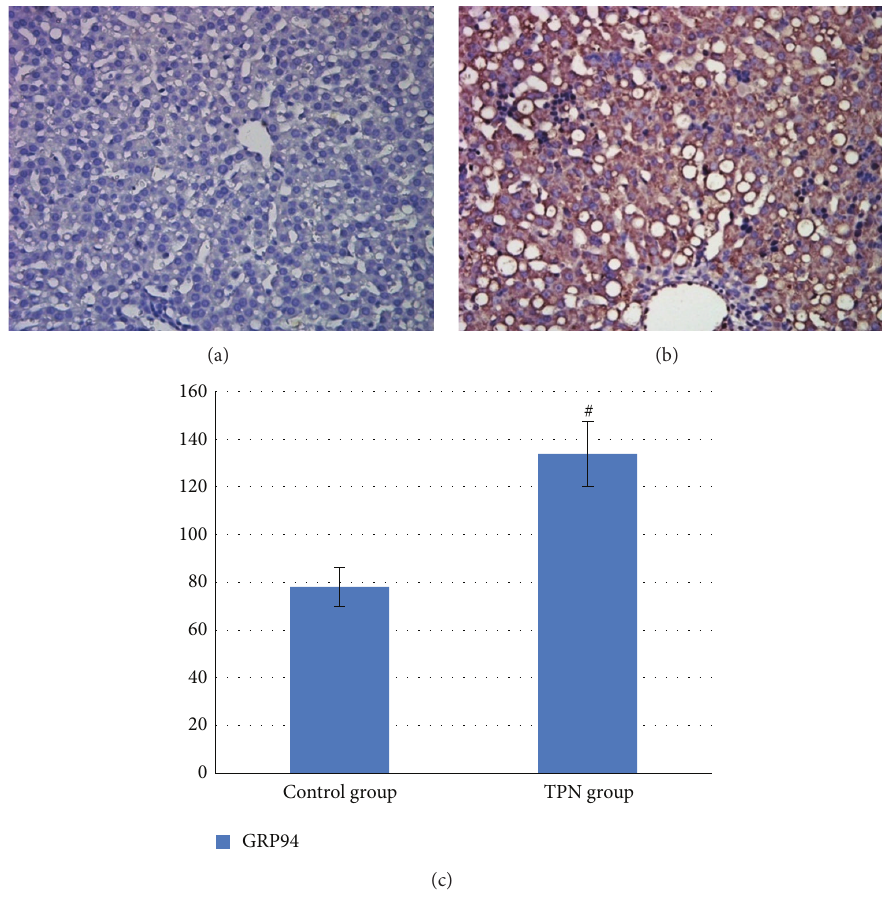
Figure 3: Representative immunohistochemical staining of GRP94 protein in liver tissue from the TPN and control groups. Note: (a) control group, 400x; (b) TPN group, 400x; and (c) a GRP94 protein expression gray value histogram of liver tissue from the two groups. Compared with the control group, # 𝑃 < 0.01